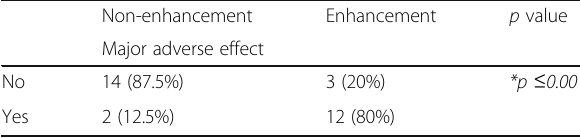
Table 6 Comparison between the percentage of major